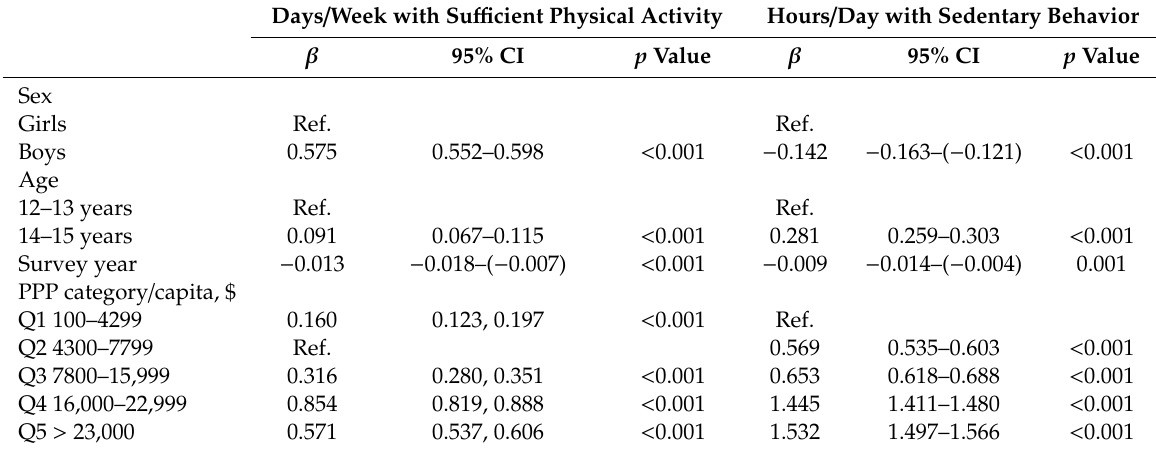
Table 2. Predictors of number of days / week with su ffi cient physical activity and of number of hours / day with sedentary behavior in adolescents aged 12–15